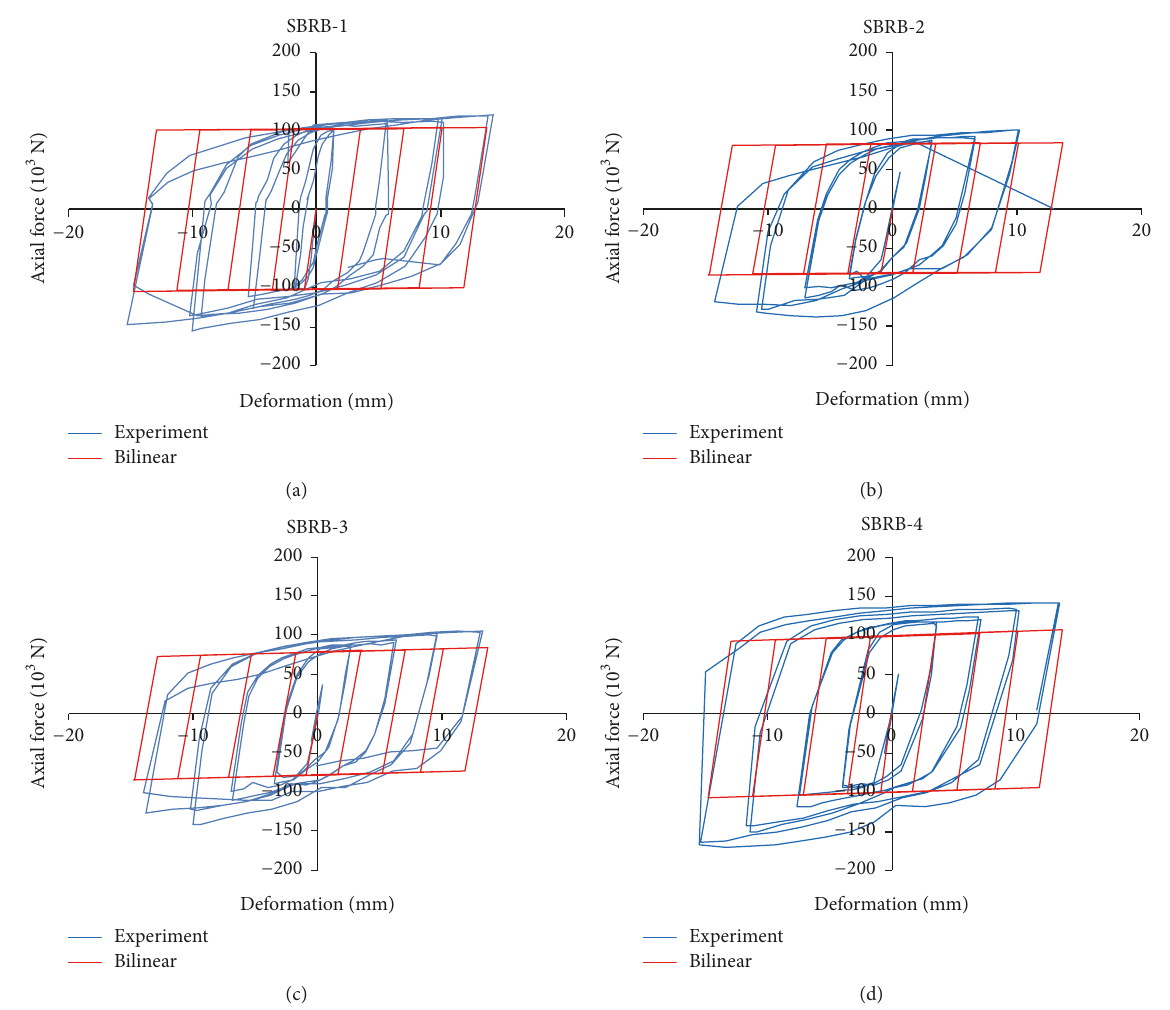
Figure 12: Hysteretic curves of SBRBs: experimental results and analytical results using the bilinear model with steel core plates of (a) 50 × 8 mm; (b) 40 × 8mm; (c) 40 × 8 mm; (d) 50 × 8mm [7].